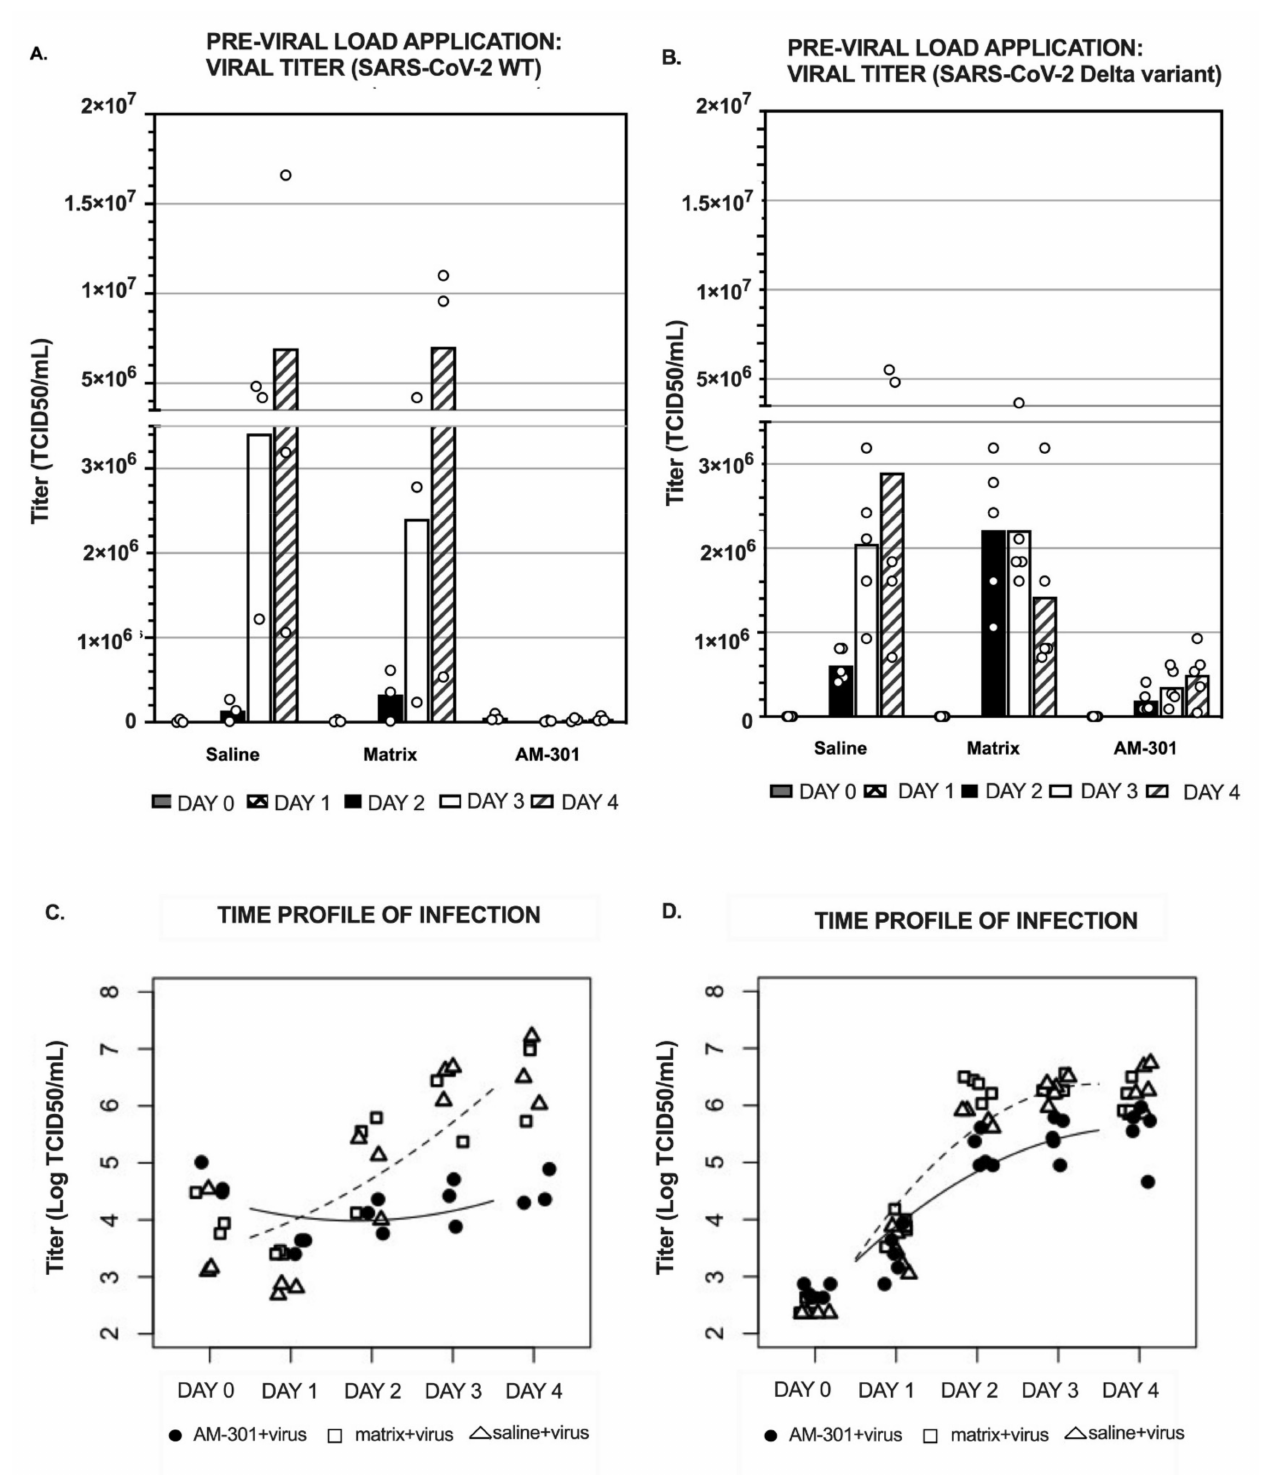
Figure 2. AM-301 as prophylaxis (pre-viral load application) against SARS-CoV-2 infection. MucilAir inserts were treated for 10 min with physiological saline, AM-301, or its matrix, followed by viral suspension for 3 h. Then, inserts were washed and incubated for up to 4 days with daily reapplication of saline, matrix, and AM-301. ( A ) Bar chart with mean values (bars) and individual data points (void circles) of inserts infected by SARS-CoV-2 WT (independent replicates, n = 3 per group). ( B ) Bar chart with mean values (bars) and individual data points (void circles) of inserts infected with